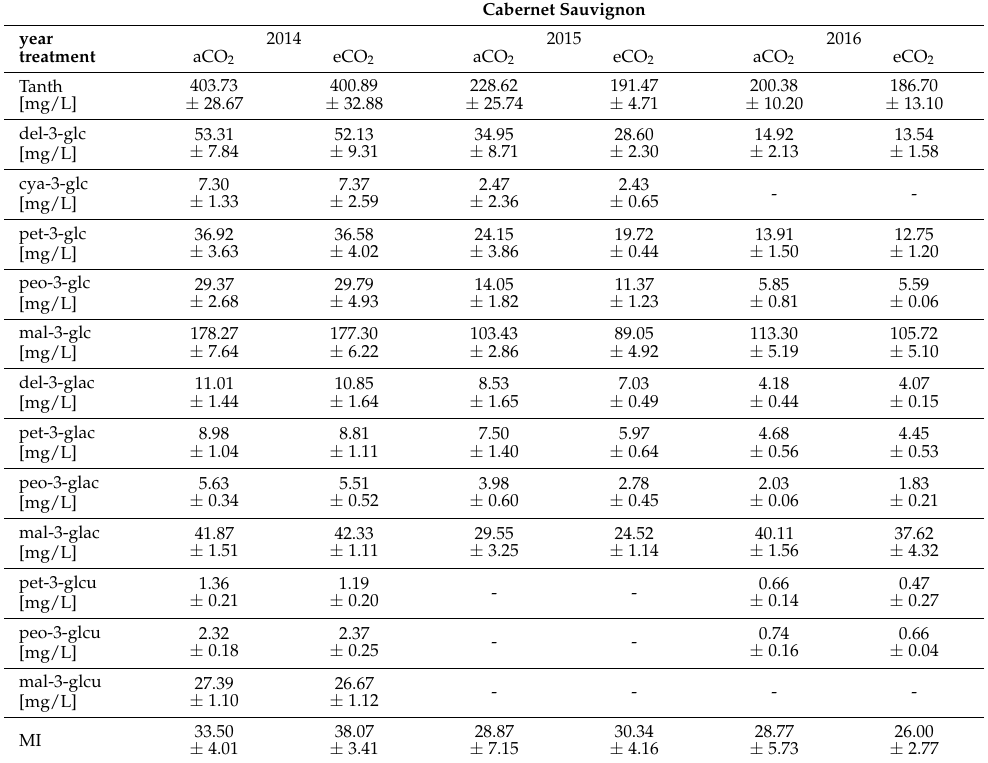
Table 5. Anthocyanins and monomeric index (MI) in cvs. Cabernet Sauvignon young wines at two CO 2 levels (aCO 2 and eCO 2 ) of vintages 2014, 2015 and